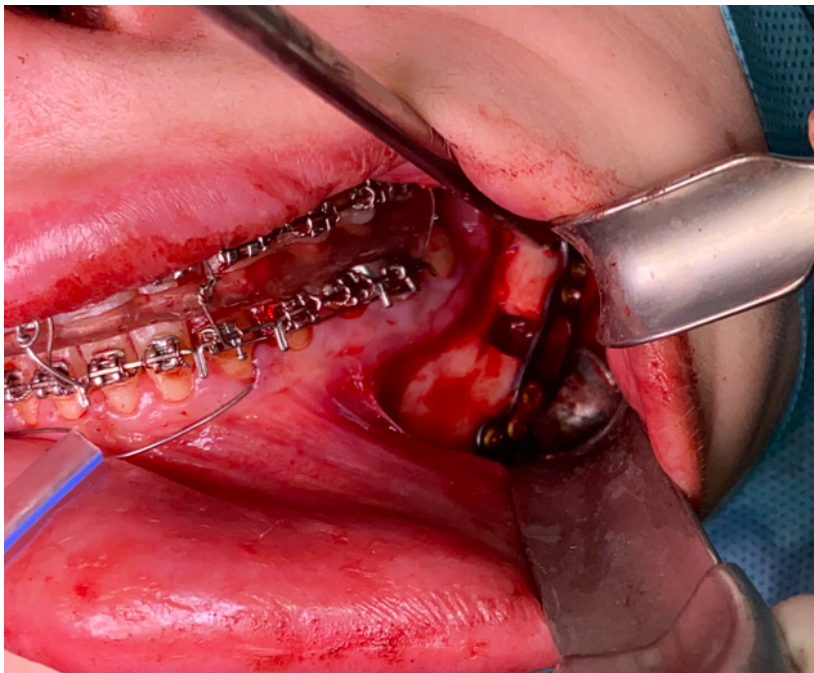
Figure 4. Intraoperative view of BSSO procedure. Titanium plate Modus 2.0 Medartis Orthognathic is fixing the bones together in a new position after mandibular advancement and rotation to restore the symmetry and balance. Superiorly to the plate, a less visible bicortical screw is visible.